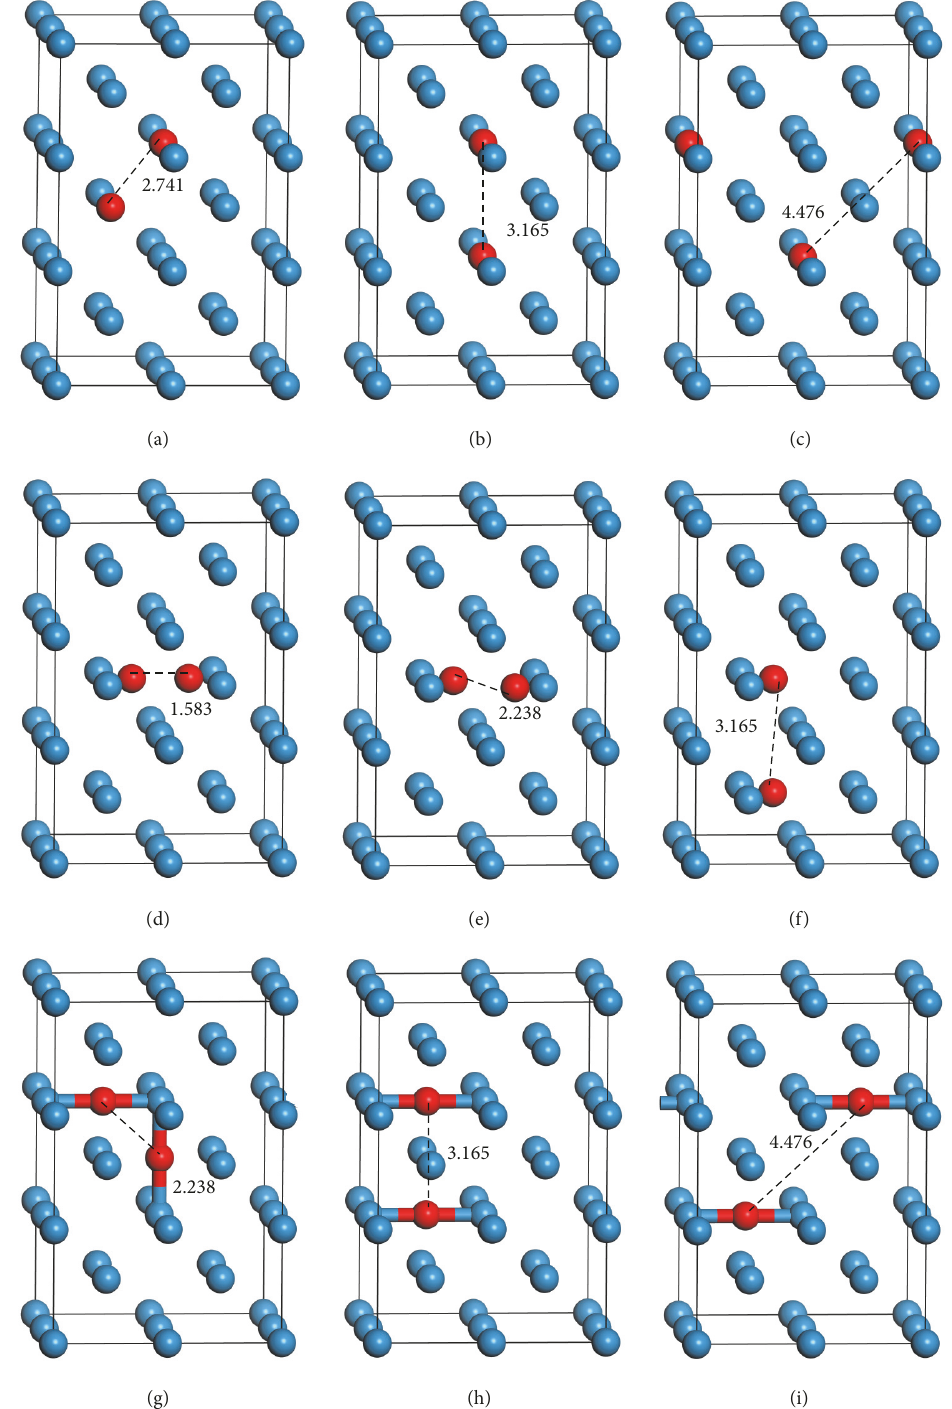
Figure 2: The crystal structure of BCC W contains two H atoms or He atoms. The blue balls and red balls stand for W atoms and the H atoms or He atoms, respectively. (a), (b), and (c) show two atoms located in the substitutional site. (d), (e), and (f) show two atoms located in the tetrahedral site, and (g), (h), and (i) show two atoms located in the octahedral site. The numbers in the figure stand for the distances (in ˚A) between the two foreign